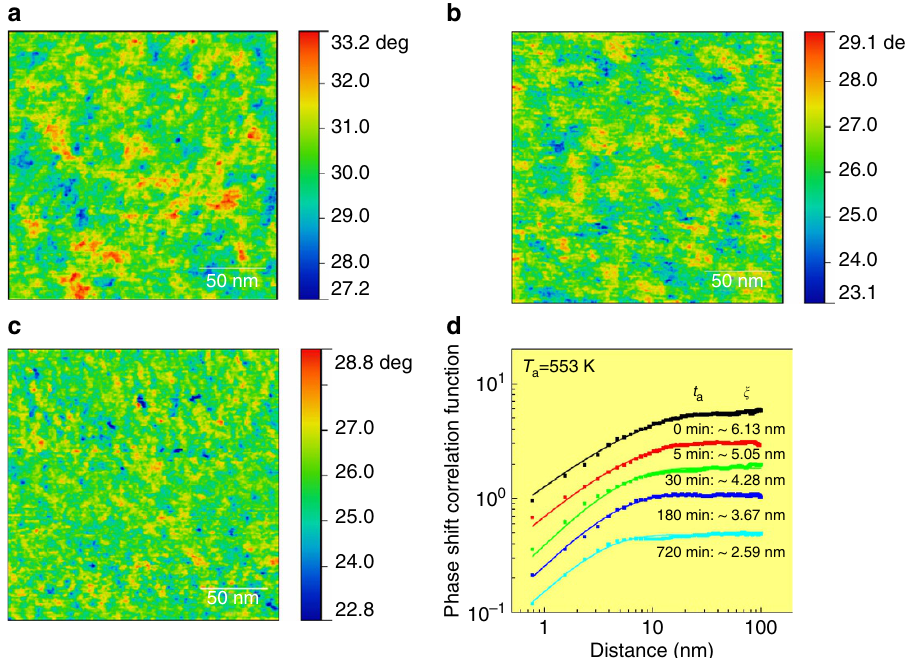
Figure 3 | Evolution of spatial heterogeneity during sub- T g relaxation at T a ¼ 553K. Phase shift images of ( a ) the hyper-quenched metallic glass, ( b ) the metallic glass relaxed at 553K for 5min and ( c ) relaxed at 553K for 720min. ( d ) Correlation function curves of the samples annealed at 553K for different durations. The correlation lengths of spatial heterogeneity in phase shift images can be determined by the correlation function curves. Note that the curves were shifted vertically for clear